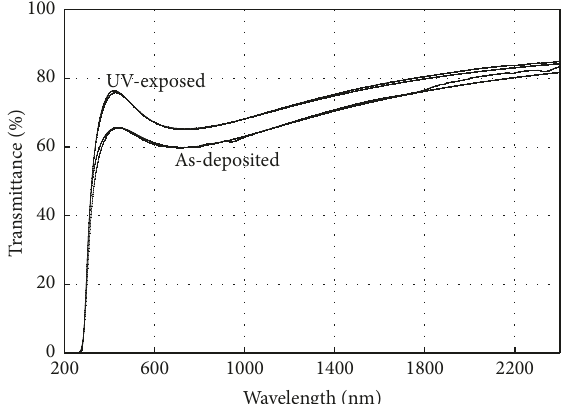
Figure 6: Comparison of experimental spectra with theory.